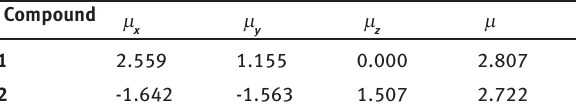
Table 1: The calculated electric dipole moments m (Debye) and dipole moment components for 1 - 2 using DFT method at B3LYP/ 6-31G( d ) level.